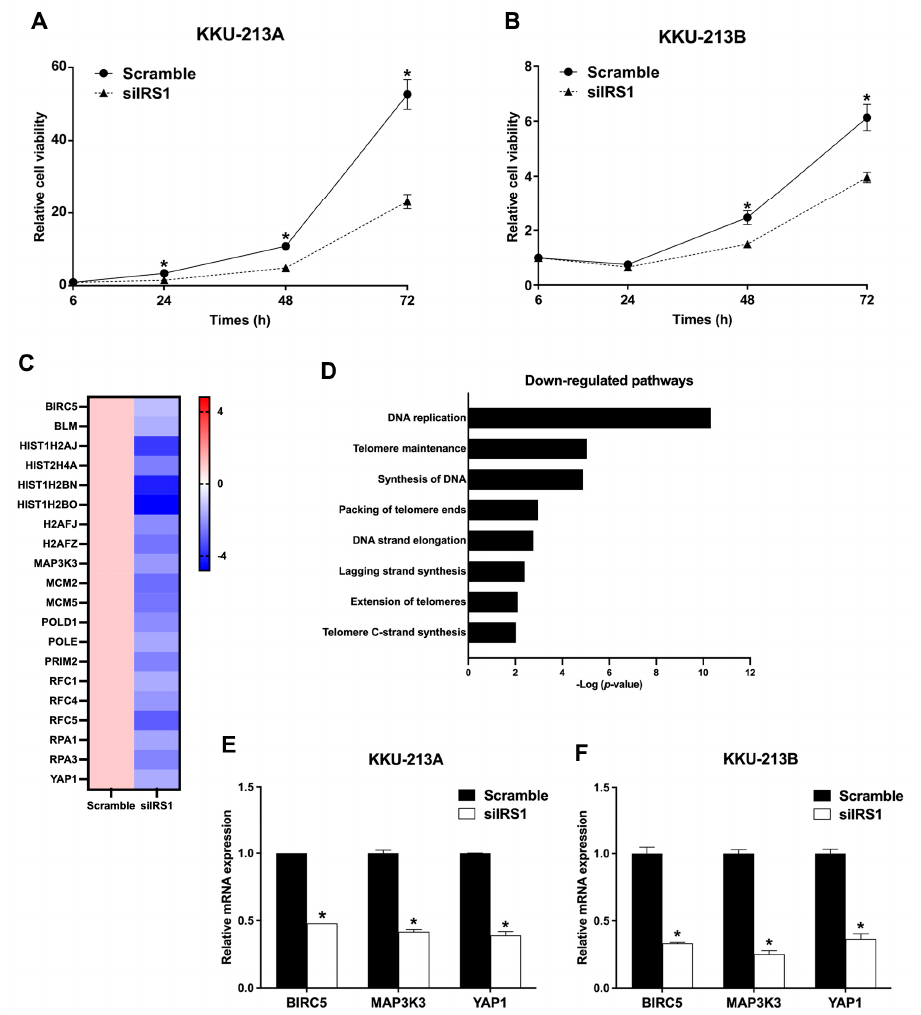
Figure 5 . Effect of IRS1 knockdown on proliferation of CCA cell lines. ( A , B ) Effect of IRS1 knock- down on cell viability of KKU-213A and KKU-213B determined by MTT assay. ( C ) Heat map rep- resenting fold changes of cell proliferation-related genes in KKU-213B after IRS1 knockdown inves- tigated by RNA sequencing. ( D ) Reactome pathway enrichment analysis revealed that many prolif- eration-related pathways were down-regulated in IRS1 knockdown cells. ( E , F ) Relative mRNA ex- pression of BIRC5, MAP3K3, and YAP1 in IRS1 knockdown CCA cells. * p -value < 0.05 compared to scramble.